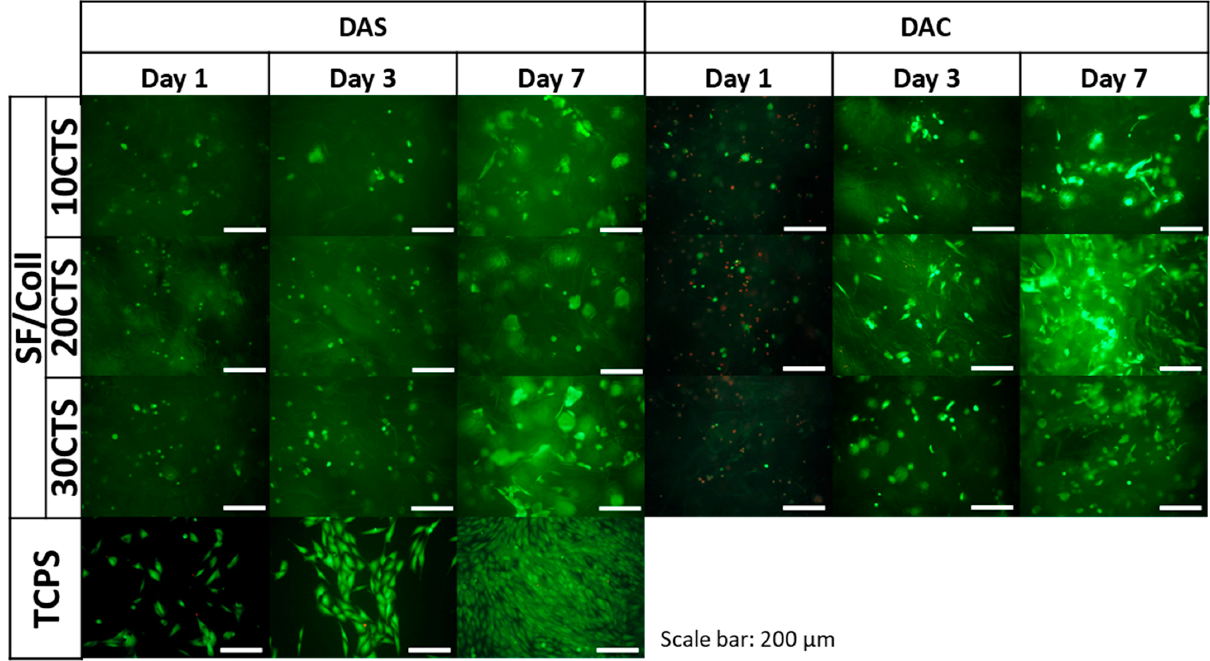
Figure 14. Images of MG-63 cells grown for one, three or seven days on SF/Coll 50/50 mixtures with 10, 20 and 30% addition of CTS, cross-linked with dialdehyde starch (DAS) and dialdehyde chitosan (DAC) scaffolds and on control TCPS. Live/dead staining. Scale bar = 200 μ m.